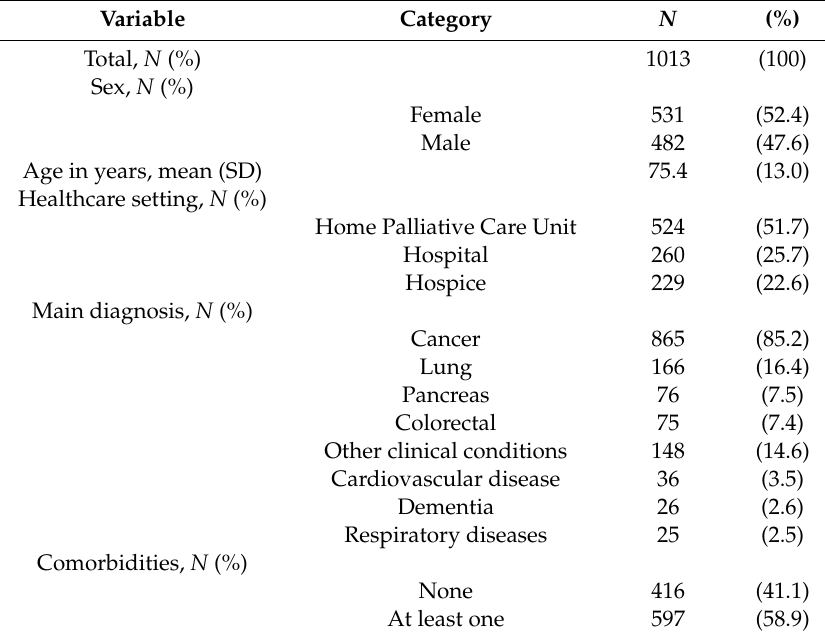
Table 2. General characteristics of the study population.